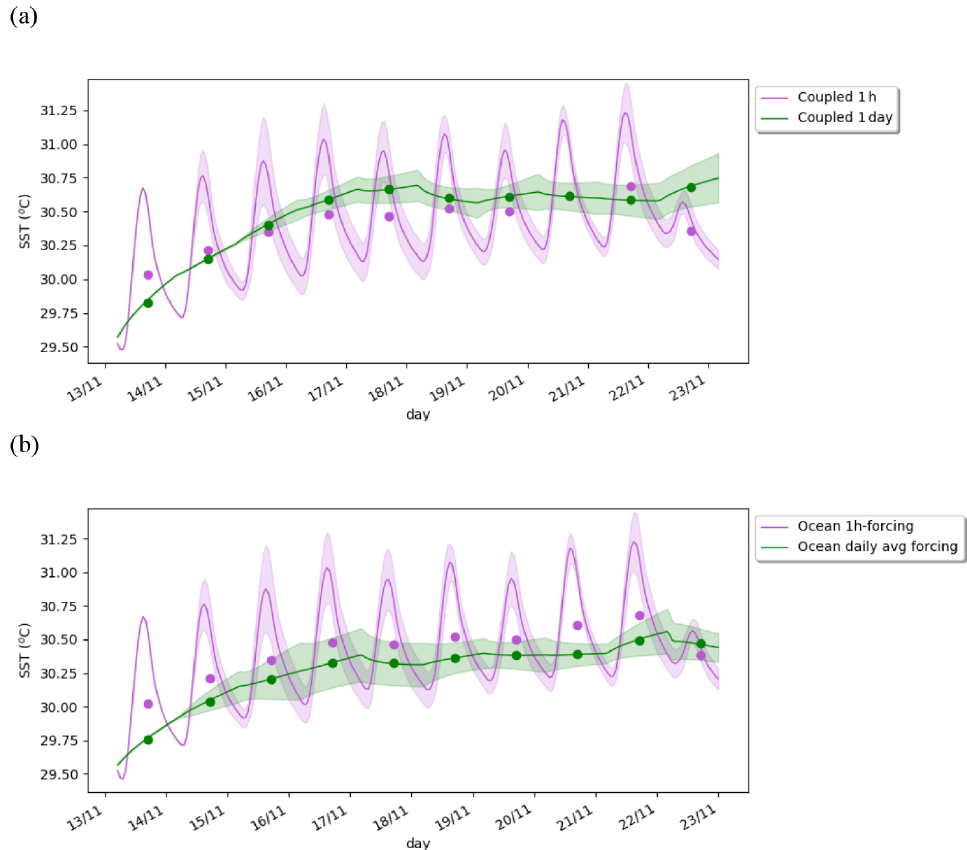
Figure 14. Evolution of SST ( ◦ C) simulated by the ocean component for (a) the hourly and daily coupled experiments as well as the (b) ocean forced experiments forced with the hourly coupled atmospheric state taken hourly or as a daily average. The dots indicate the daily mean SST values for each